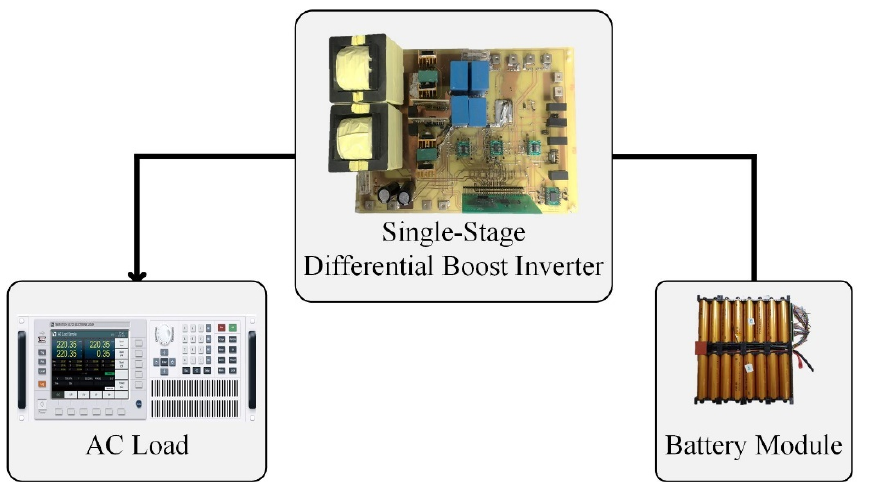
Figure 11. System connections of the SSDBI.